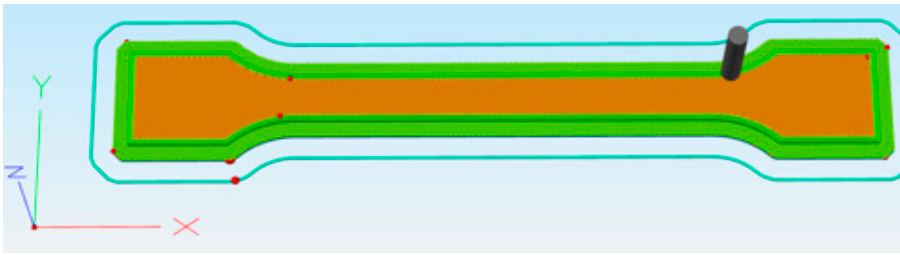
Figure 9. Improperly chosen starting points.